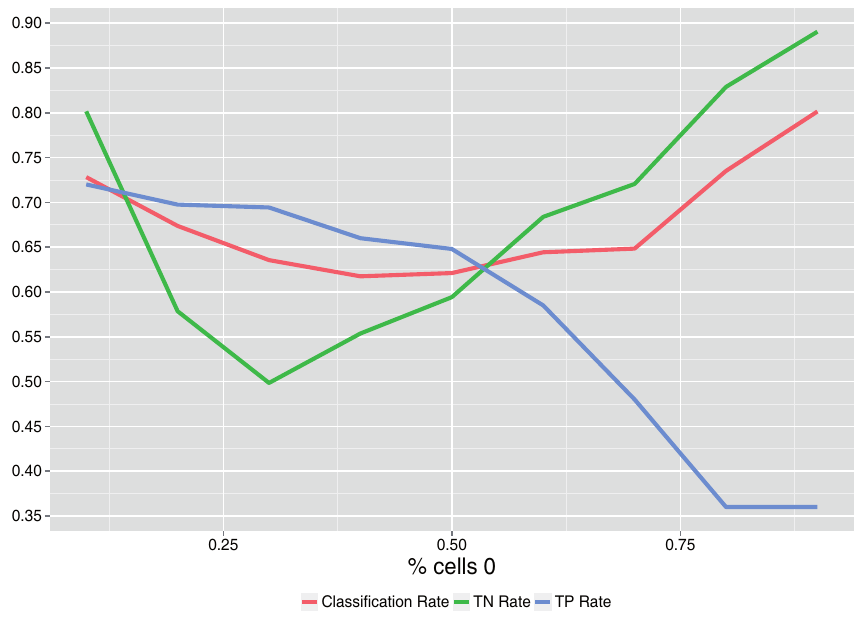
Figure 5. Classification rate, true positive rate and true negative rate vs. the percent of cells of zero.